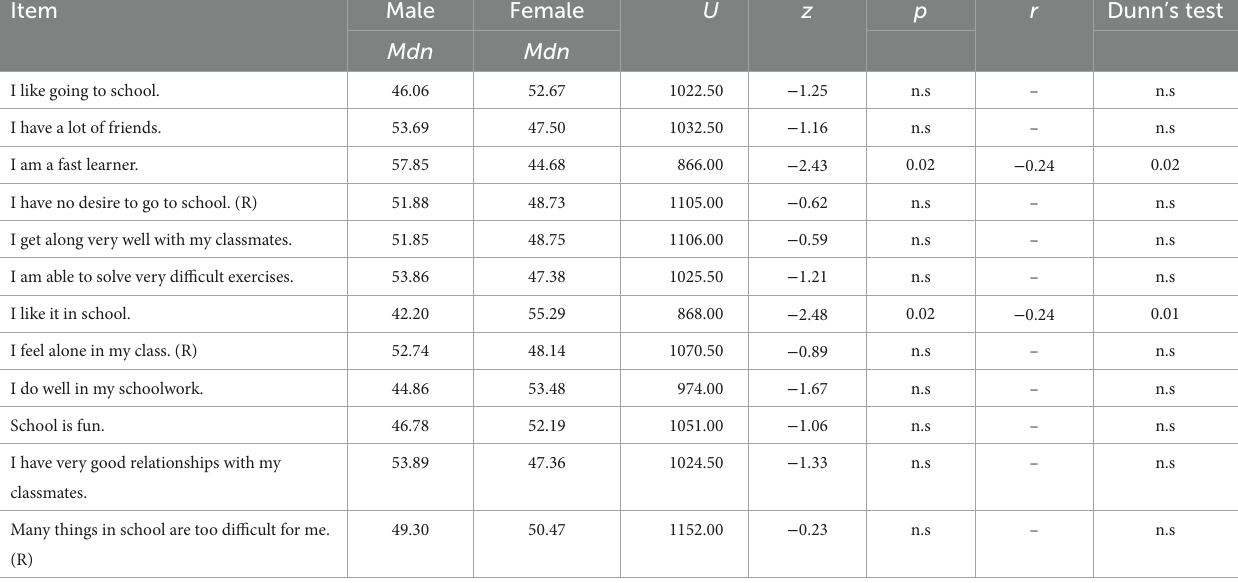
TABLE 3 Medians, Mann–Whitney U and Dunn’s tests by sample and effect size ( N = 101). Item